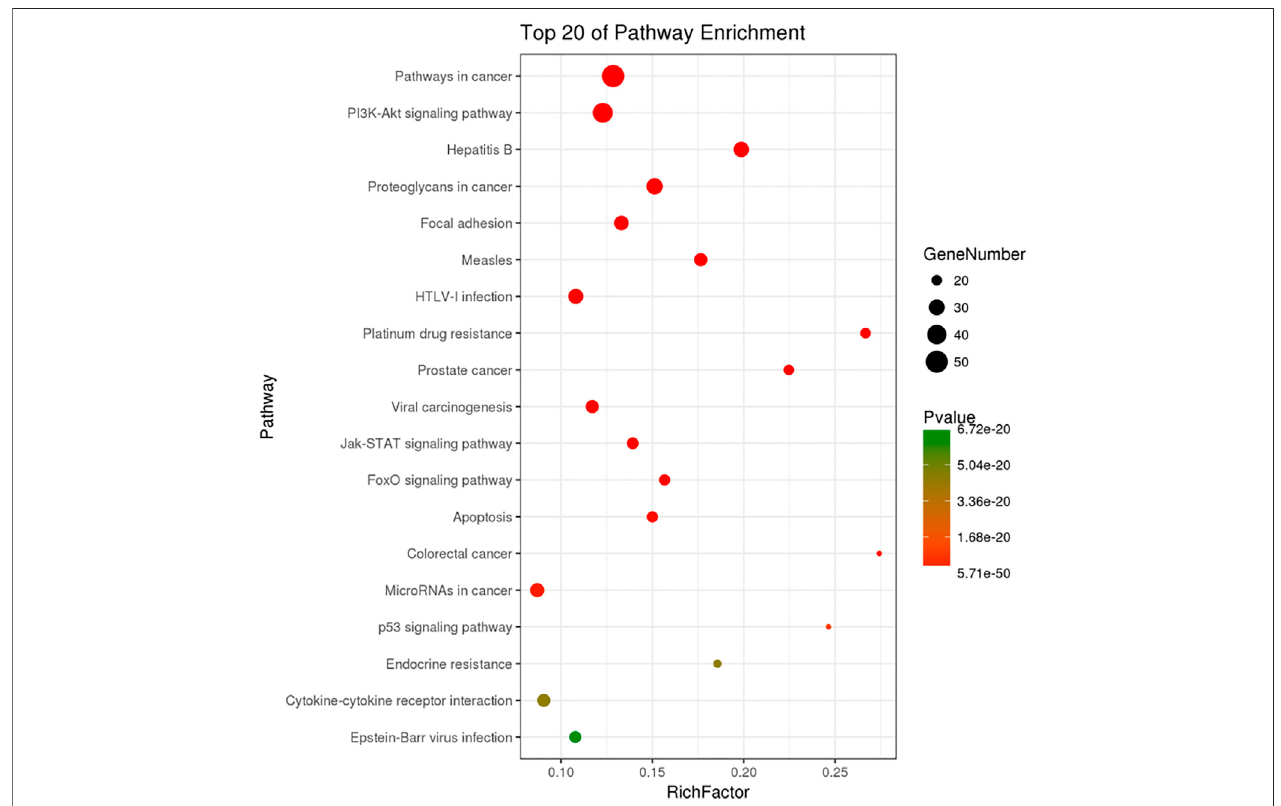
FIGURE 5 | KEGG pathway enrichment of candidate targets for G-Rh2 in lung